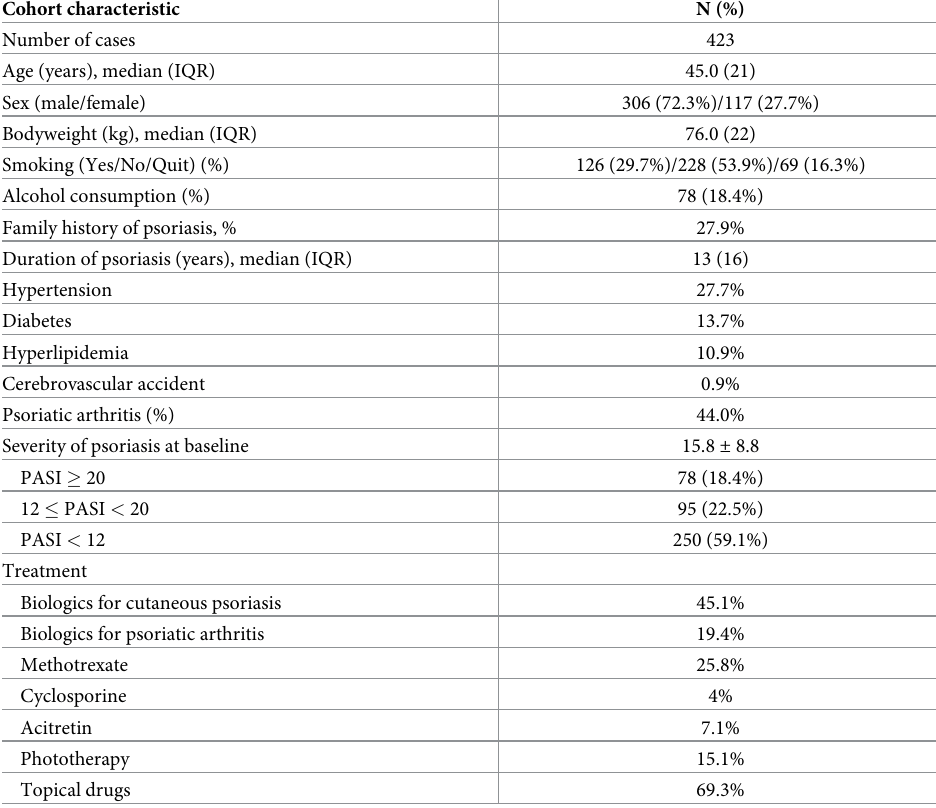
Table 1. Participant demographic and disease